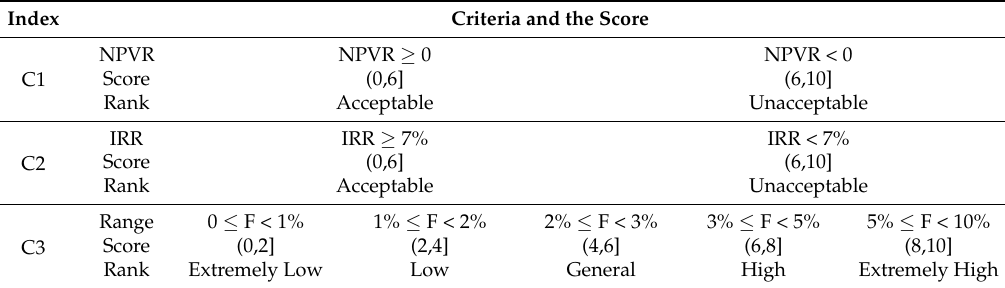
Table 6. Evaluation criteria of the economic